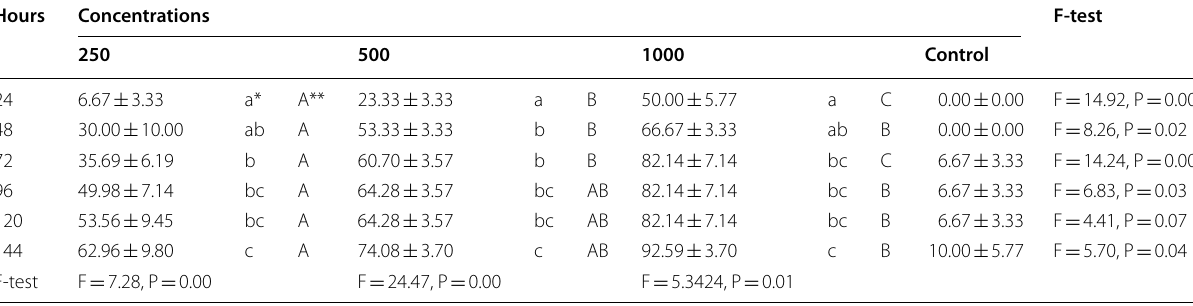
*Means within column bearing the same letter are not significantly different (Duncan’s test, p > 0.05) **Means within lines bearing the same letter are not significantly different (Duncan’s test, p >